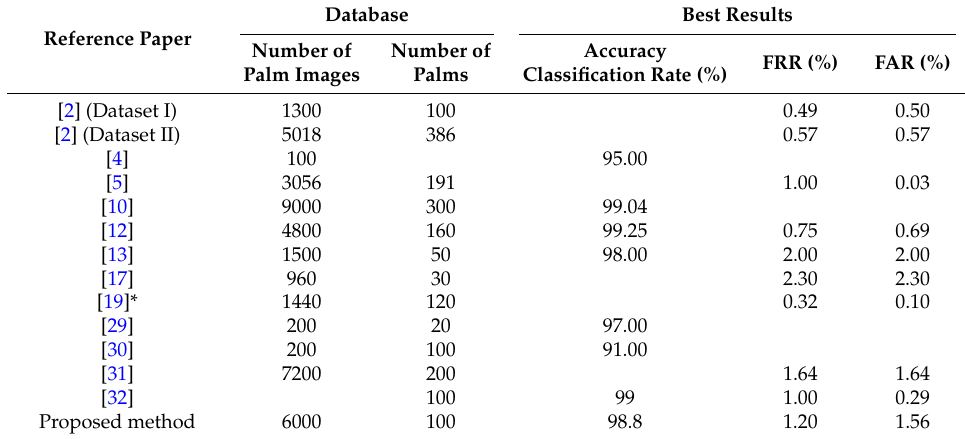
Table 1. Comparison of palmprint or palm vein verification methods and the proposed method which fuses palmprint and vein pattern images.